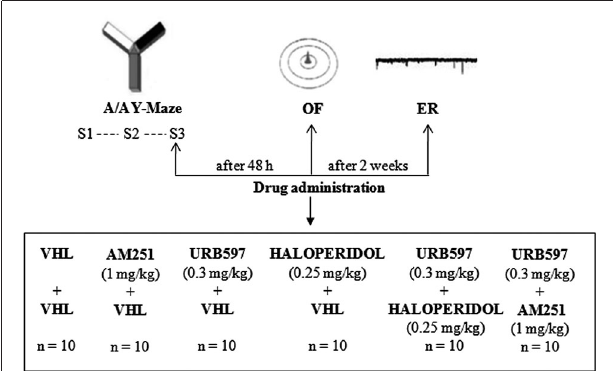
FIGURE 1 | Procedures and global timing of experimental design. C57BL/6J mice were tested in the Approach/Avoidance Y-Maze (A/A Y-Maze) and in the Open Field (OF) test. At the end of behavioral testing, Electrophysiological Recordings (ER) were performed from medium spiny neurons of the dorsomedial striatum. Drugs were administered before S3 of A/A Y-Maze and OF task as well as before